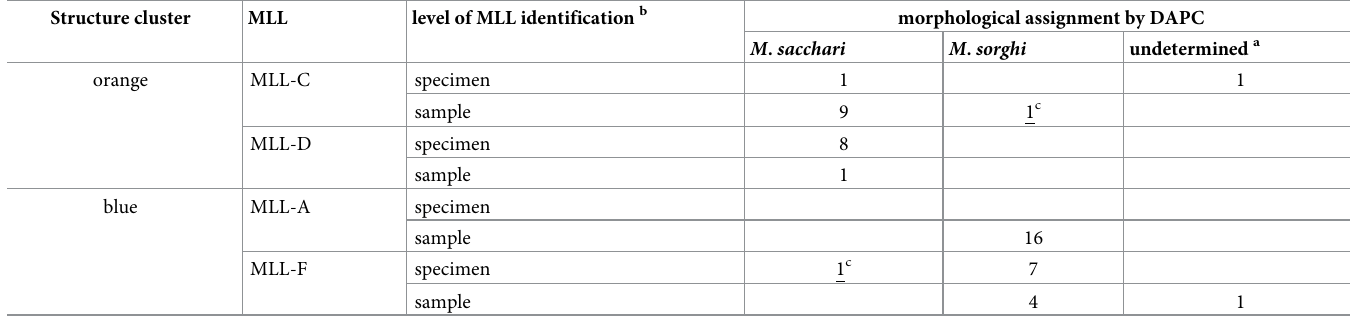
Table 3. Multi Locus Lineage (MLL) identification of the 51 slide fixed specimens morphologically assigned to M . sorghi or M . sacchari by DAPC. Structure